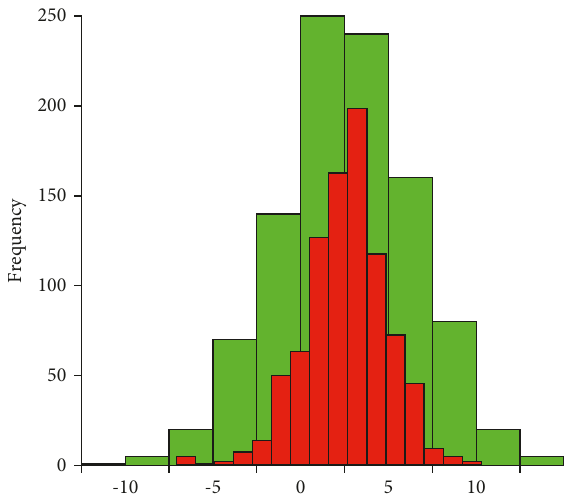
Figure 8: Statistical results predicted by two